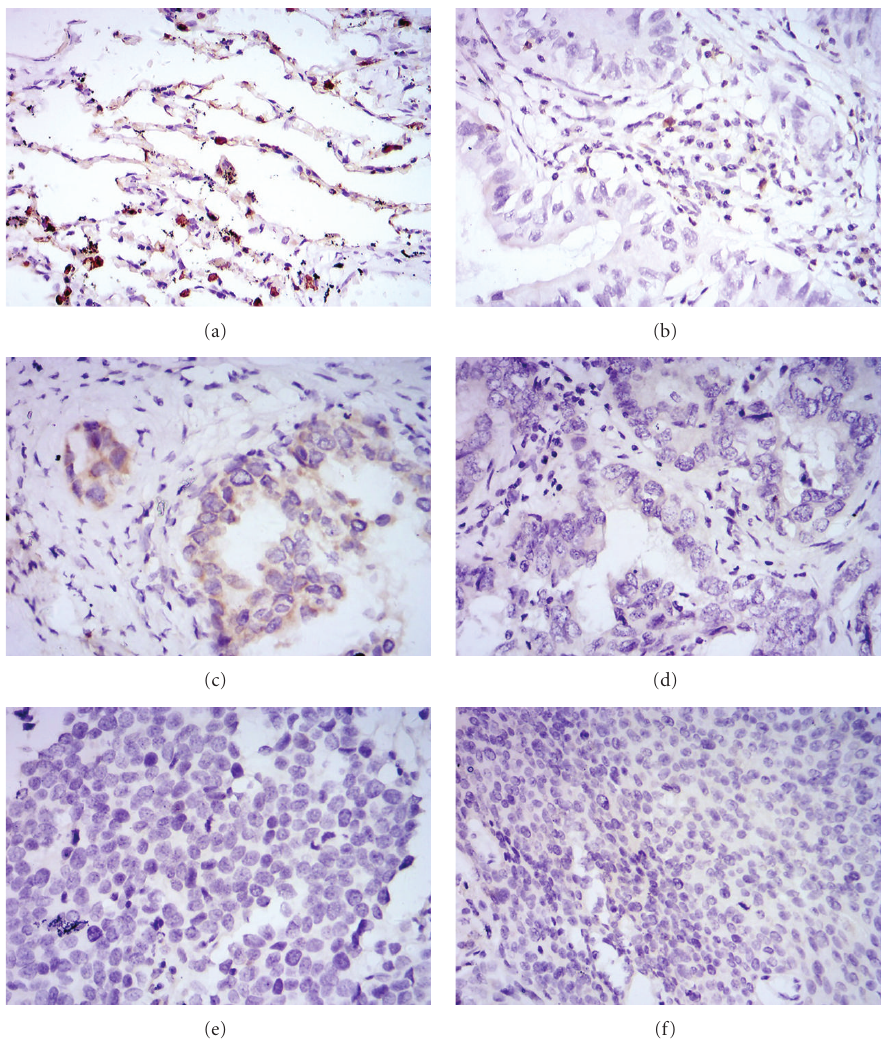
Figure 4: Immunohistochemistry staining in tissue chip of SCCA1 protein expression in lung cancer tissue and normal tissues ((a) normal lung tissue, (b) lung squamous cell carcinomas, (c) metastatic carcinoma, (d) adenocarcinoma, (e) small cell carcinoma, (f) large cell carcinoma tissues).